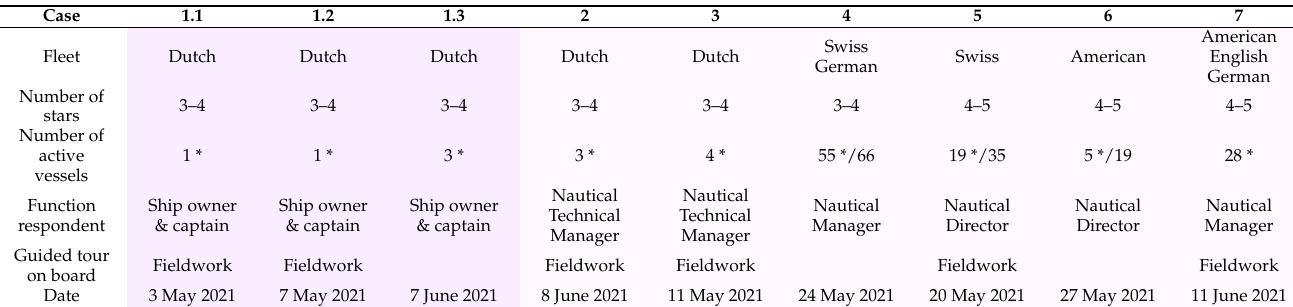
Table 1. Overview of the case